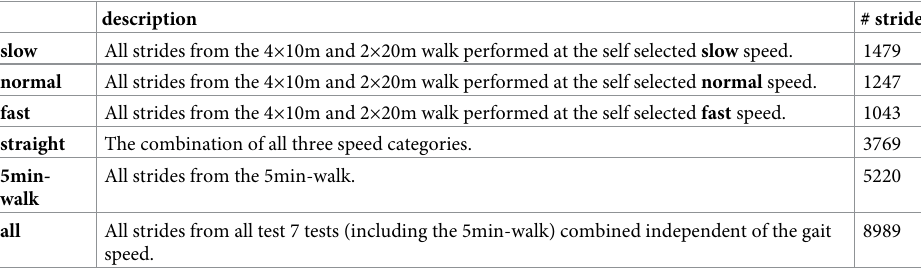
Table 2. Overview over the stride categories and the respective number of strides.